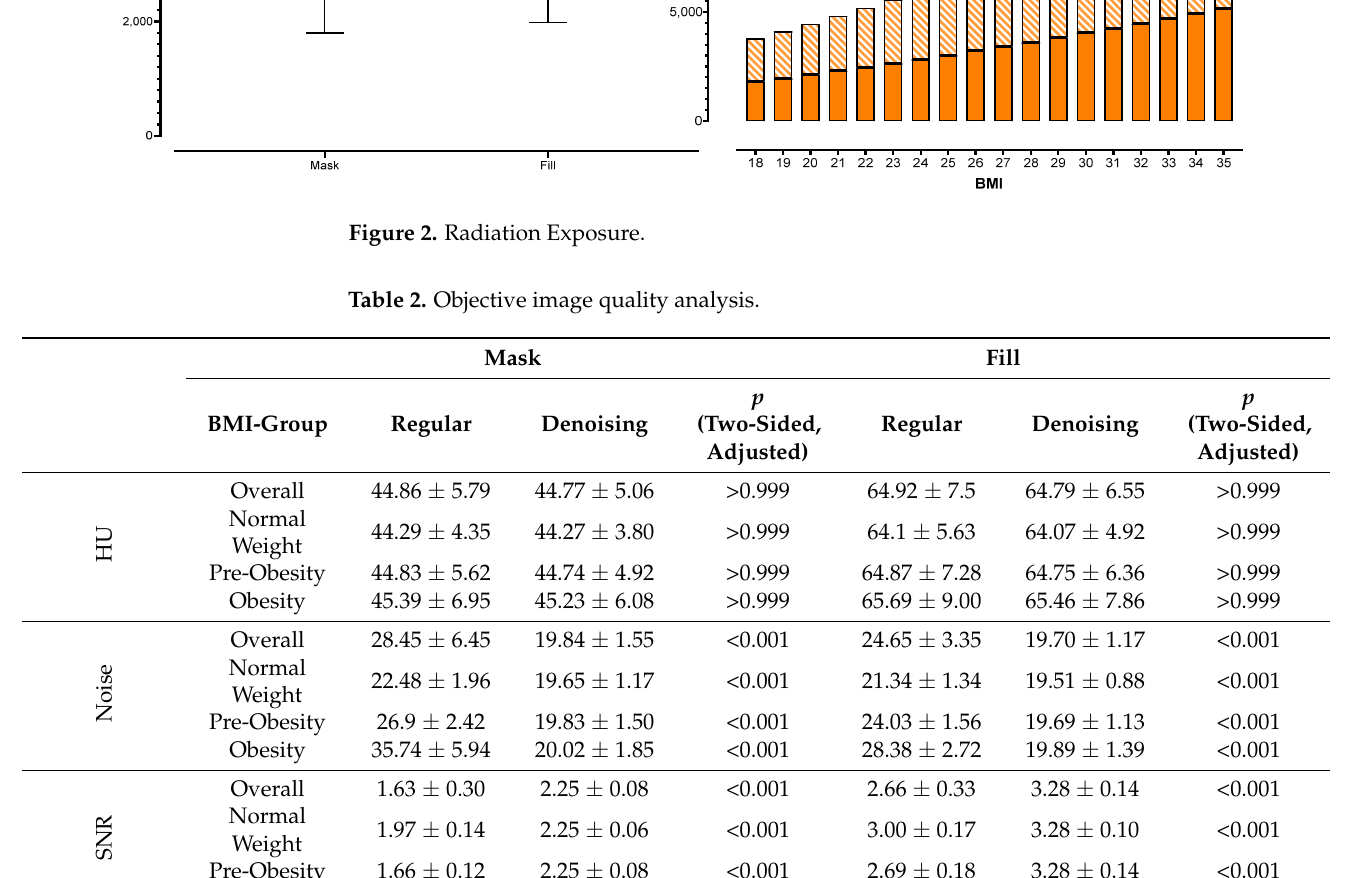
Table 2. Objective image quality analysis.